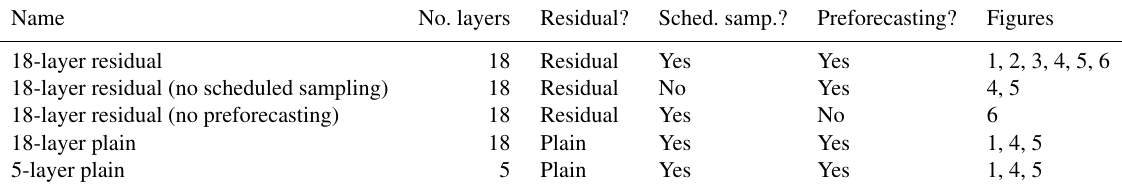
Table 1. Description of all of the neural-network architectures used in this study, including the number of layers, whether the network is a residual or plain network (plain networks do not have shortcut connections), whether scheduled sampling was used, whether preforecasting was used, and the figures of the paper in which each network is used. In addition, these results are compared with persistence forecasting and an autoregressive model. Table A1 provides information about the hyperparameters used for each configuration, and Table A2 describes the hyperparameter space used in model